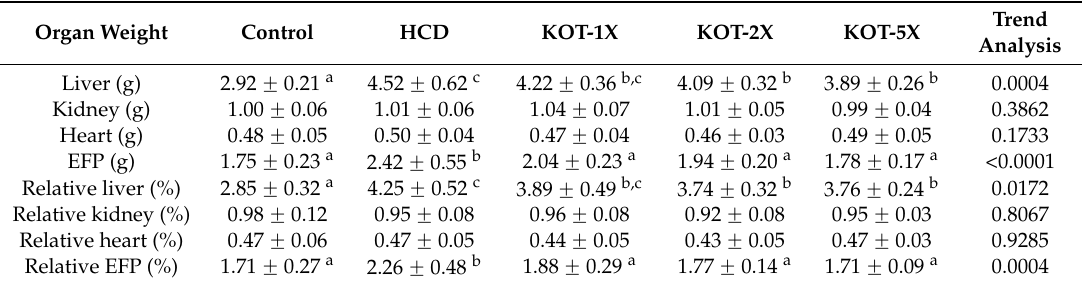
Table 3. Tissue weights at the end of the